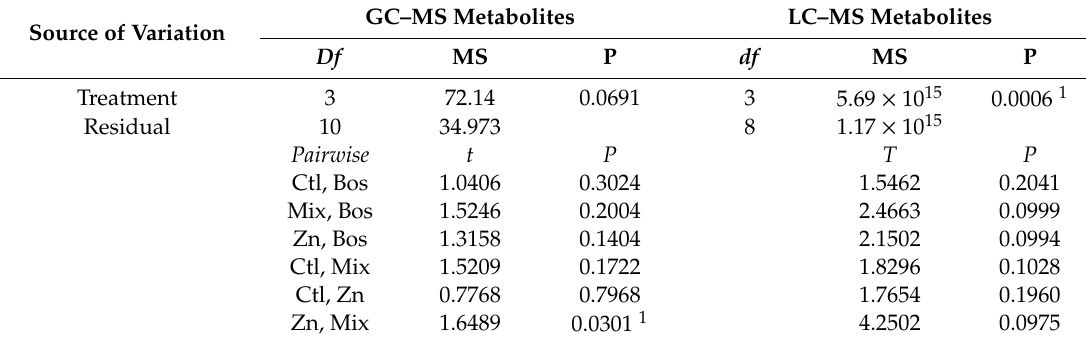
Table 1. PERMANOVA, multivariate analysis for metabolite changes to treatment as main e ff ect. Pairwise comparison analysis for each